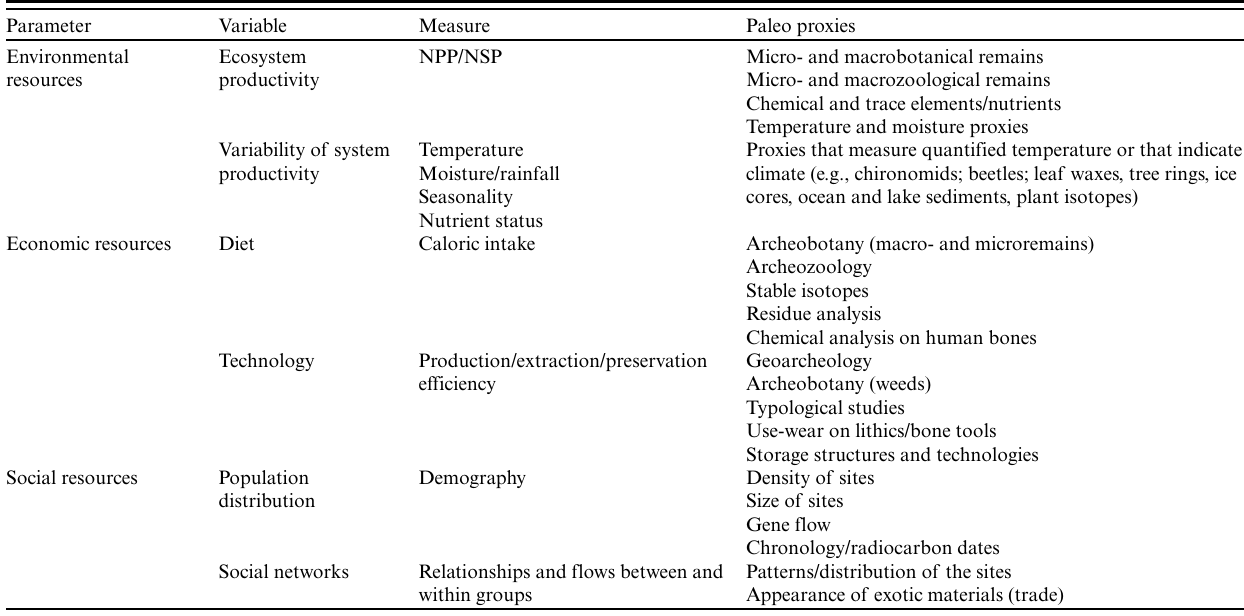
Table 1 . Summary of the variables presented in the paper, with an indication on proxies for measuring them in past social-ecological systems.